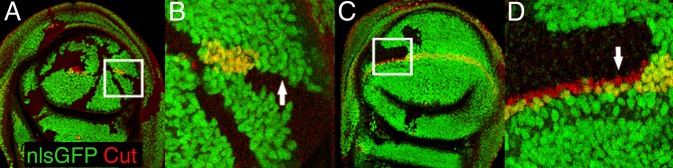

D-mib Is Required in Dorsal Cells for Margin Expression of CutLarge dorsal clones of D-mib2 mutant cells (marked by the loss of nuclear GFP, in green) resulted in a complete loss of Cut (red) expression (A and B). This indicates that D-mib is required for Ser signaling by dorsal cells. In contrast, ventral clones did not prevent the expression of Cut (C and D), implying that D-mib is not strictly required for Dl signaling. Note that mutant ventral cells abutting wild-type dorsal cells expressed Cut (arrow in [D]), indicating that D-mib is not required for N signal transduction. Low-magnification views of the wing portion of the discs are shown in (A) and (C). (B) and (D) show high-magnification views of the areas boxed in (A) and (C), respectively.